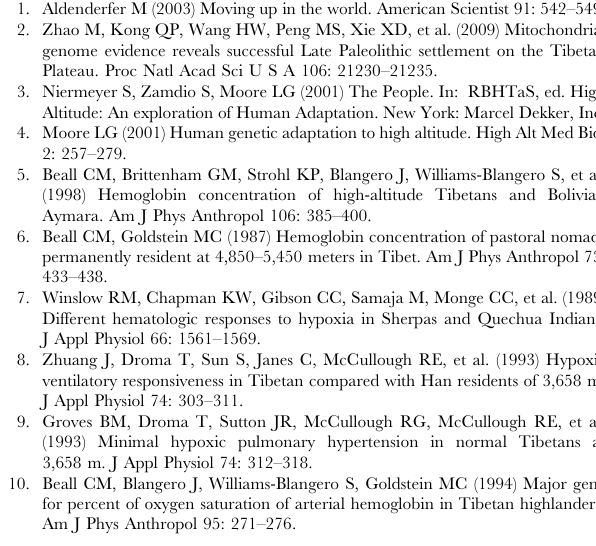
Table S3 The total and significant number of LSBL SNPs, ln RH and Tajima’s D SNP windows for HIF , RAS , and globin candidate genes in Andeans.